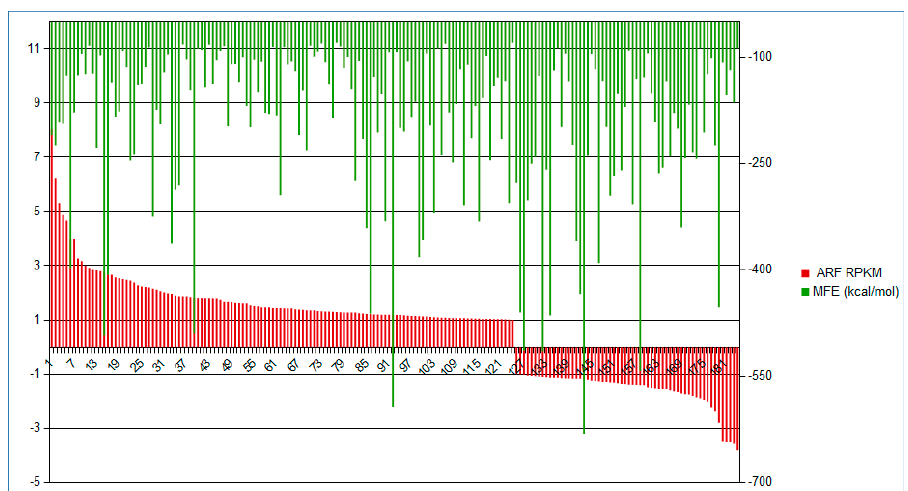
Figure 9. Predicted MFE value and lncRNA relative expression RPKM: The regulated 186 conserved lncRNAs, which were folded to predict their secondary structure stability and presented MFE below − 80 kcal/mol. The red bars represent the expression regulation (log2FC) of each lncRNA from ARF samples in comparison to CER. The green bars are the transcripts respective MFE value.